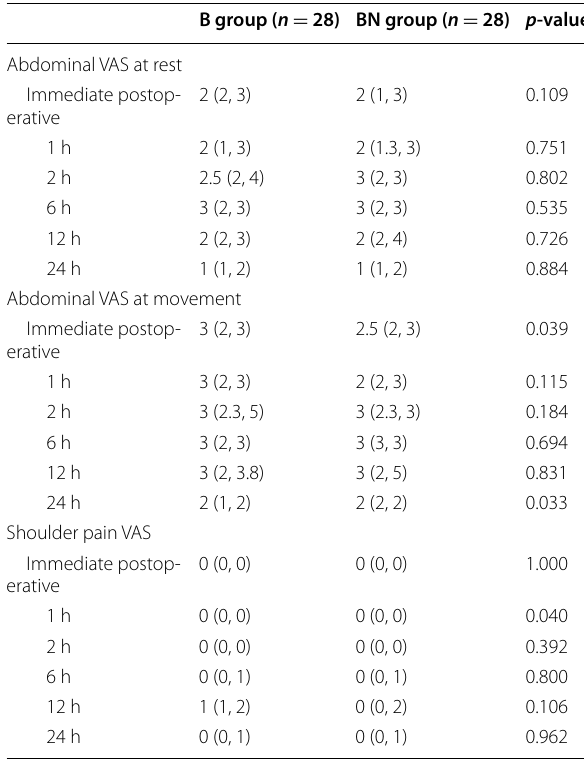
Table 3 Postoperative abdominal VAS at rest and during movement and shoulder VAS. Data presented as